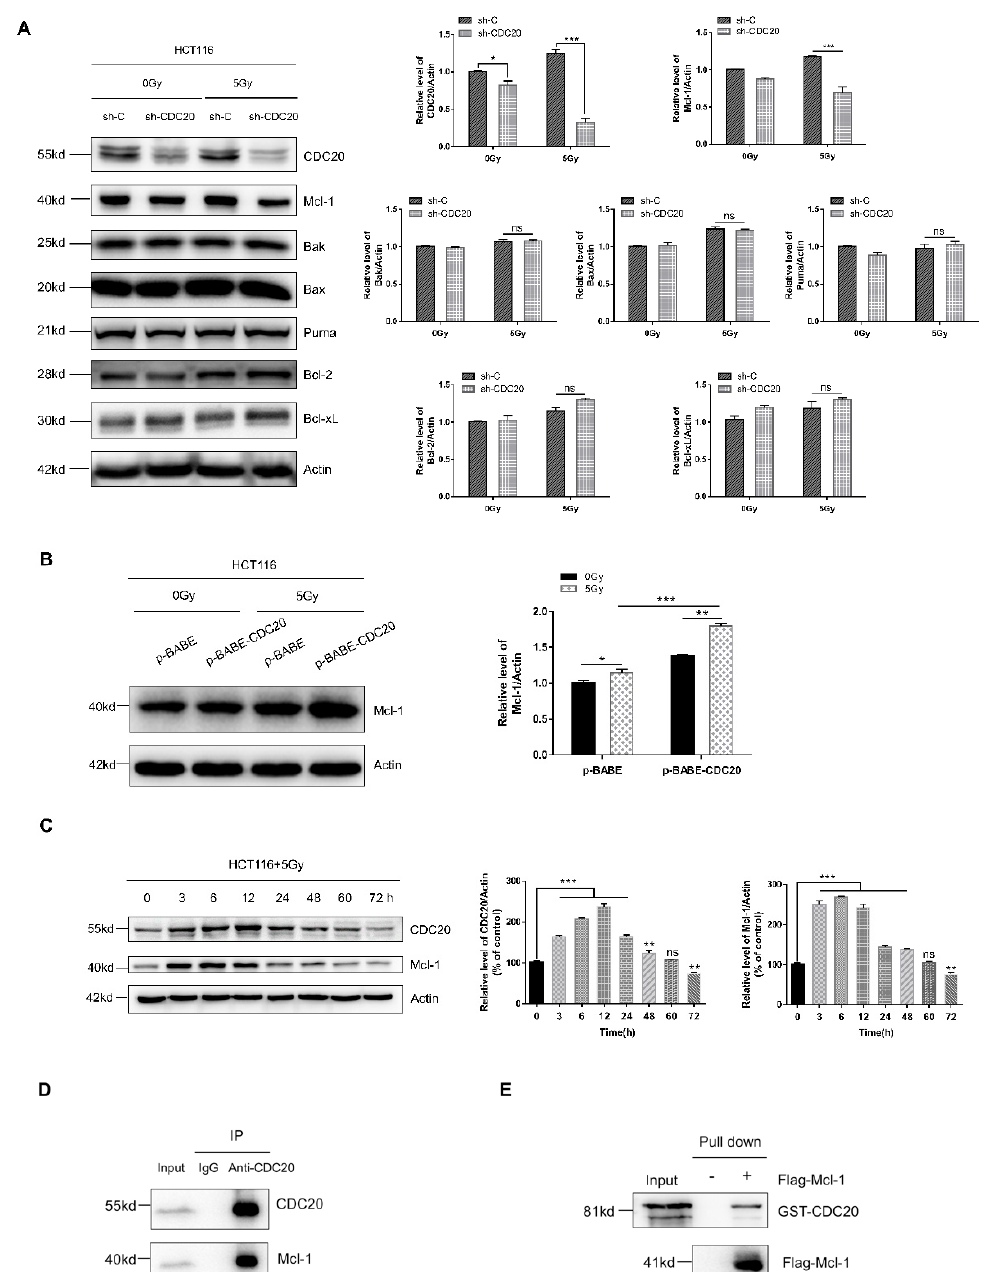
Figure 3. CDC20 inhibits radiation-induced apoptosis signals by interacting with Mcl-1. ( A ) The expression levels of Mcl-1, Bak, Bax, Puma, Bcl-2, and Bcl-xL were detected by immunoblotting analysis in CDC20 knockdown HCT116 cells compared with control vector cells 24 h after 5 Gy gamma-ray irradiation. ( B ) The expression level of Mcl-1 was determined by immunoblotting analysis in CDC20-overexpressing HCT116 cells compared with control vector cells 24 h after 5 Gy gamma-ray irradiation. ( C ) After irradiating with 5 Gy gamma-rays, the expression levels of CDC20 and Mcl-1 were detected by immunoblotting analysis at di ff erent time points. ( D ) Interaction of endogenous CDC20 with Mcl-1 was examined by Co-immunoprecipitation assay in HCT116 cells. ( E ) Purified Flag-Mcl-1 immobilized on beads was incubated with purified glutathione S-transferase (GST)-CDC20. Input and bead-bound proteins were analyzed by immunoblotting with anti-CDC20 antibody. Actin was used as an internal control. Data were pooled from three independent experiments and the results are represented as mean ± SD; * p < 0.05, ** p < 0.01, *** p < 0.001. ns = non